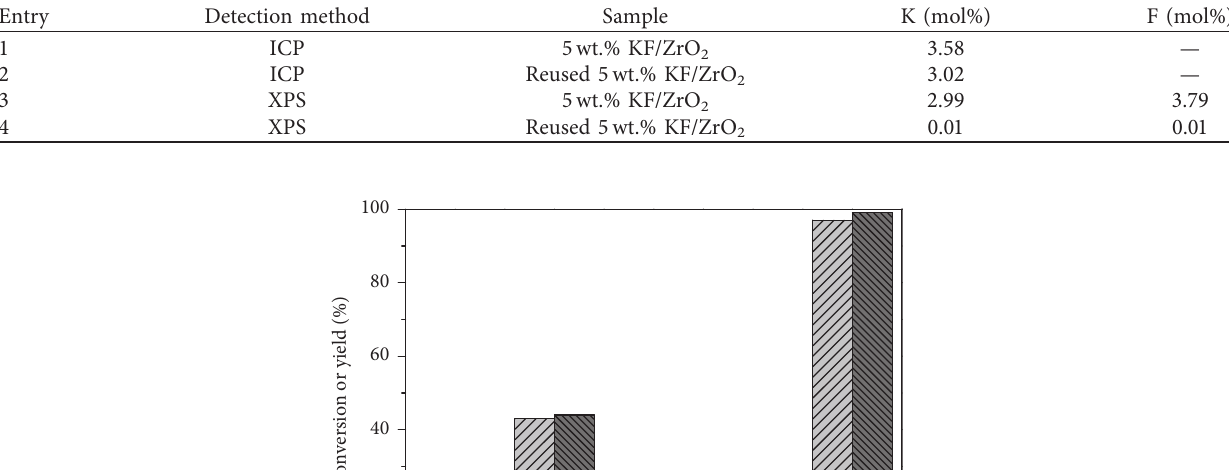
Table 2: Composition of the fresh and reused catalysts detected by XPS and ICP analysis.